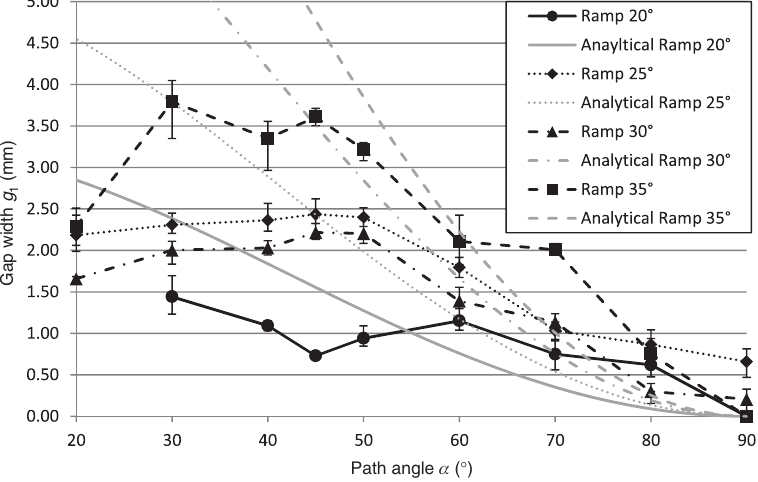
Figure 26 Experimental gap width g